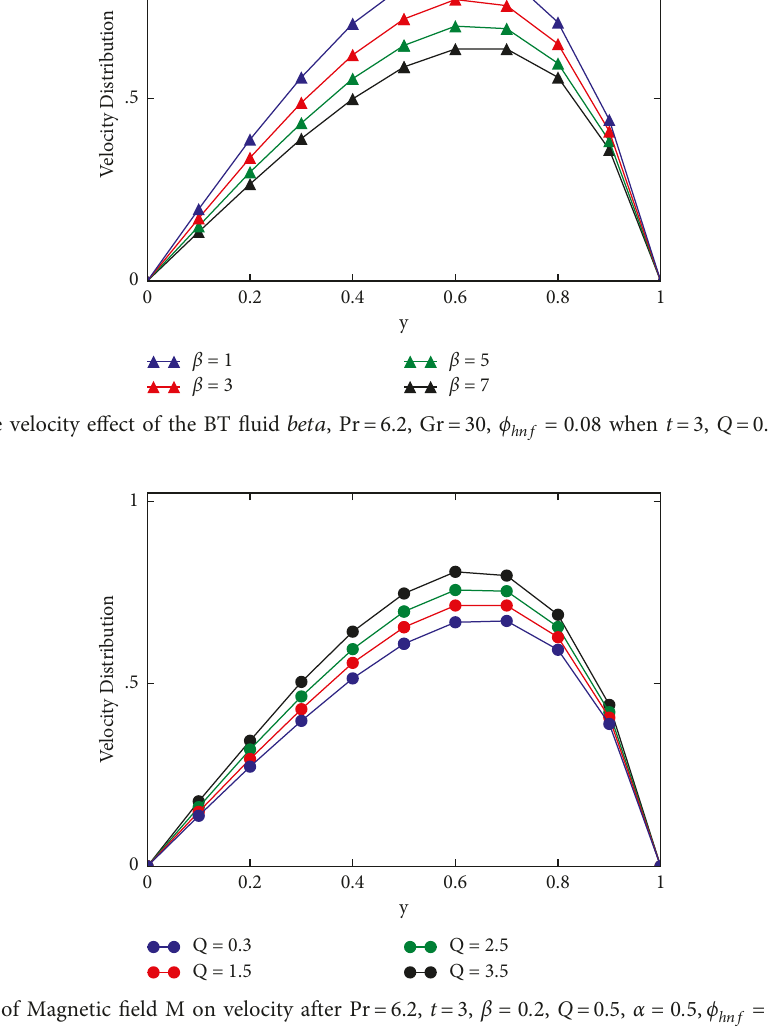
6.2, t 3, β 0 . 2, Q 0.5, α 0 . 5 , ϕ hnf (cid:30) (cid:30) (cid:30) (cid:30) (cid:30)